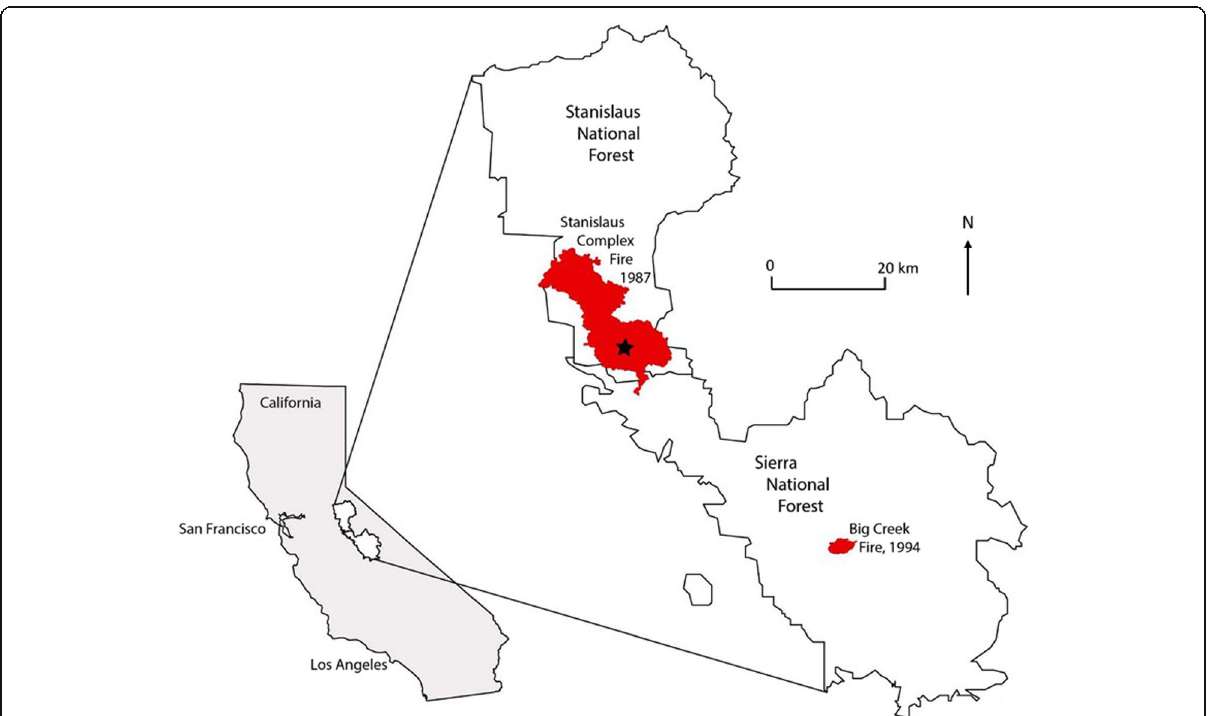
Fig. 1 Location map showing the area of the 1987 Stanislaus Complex Fire (red). The black star within the red area shows where the later Pilot Ridge debris flow occurred. The smaller red area is represents the fire-affected area of the 1994 Big Creek Fire. Both wildfires affected forested terrain within designated national